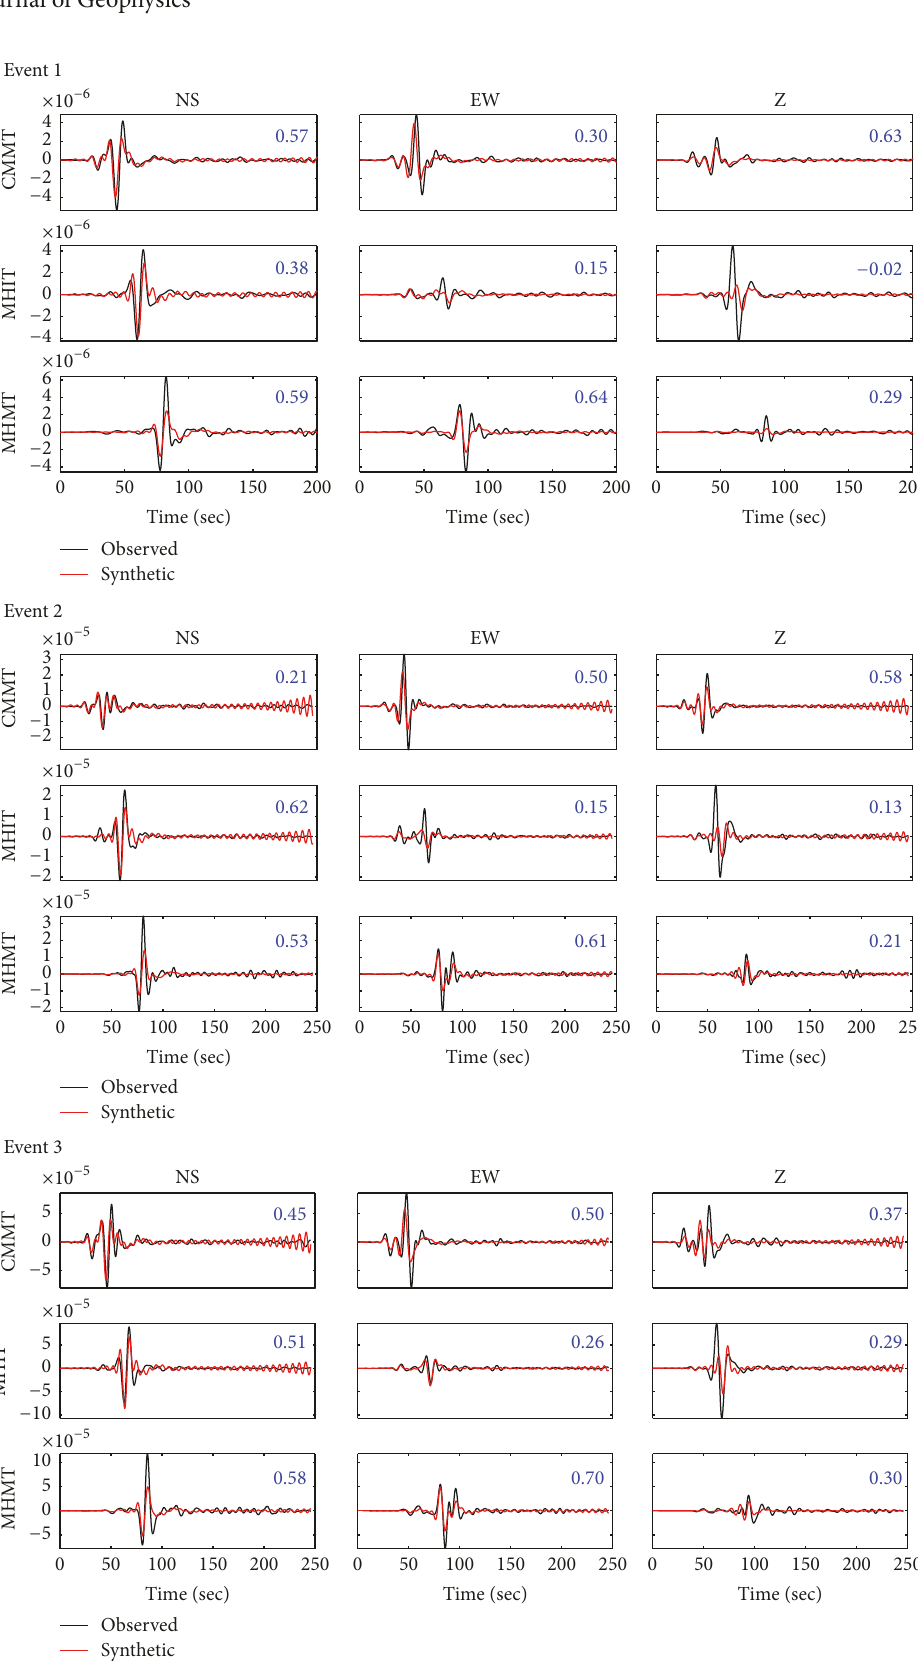
Figure 4: Results from the DMT inversion in the selected frequency range of 0.03–0.15 Hz show good fitting of synthetic (red line) and observed (black line) waveforms. Blue texts are var .red. as described in